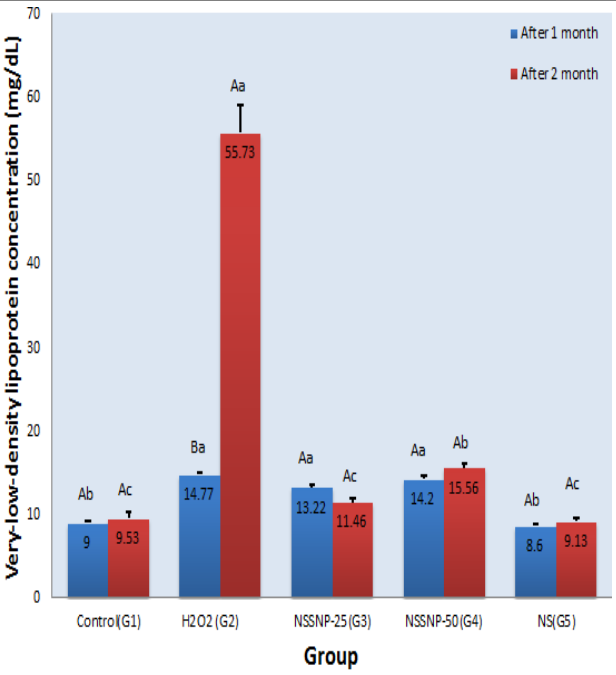
Figure 8 . Effect of two concentrations of Nigella sativa seeds silver Nanoparticles NSSSNPs and Nigella sativa Figure 7. Effect of two concentrations of Nigella sativa extract on serum high-density lipoproteins seeds silver Nanoparticles NSSSNPs and Nigella sativa concentration (mg/dl) in H O exposed rats. Values are 2 2 extract on serum very-low-density lipoproteins expressed as mean±SE (n= 8). Various capital letters concentration (mg/dl) in H O exposed rats. Values are 2 2 denote significant differences P<0.05 between expressed as mean±SE (n= 8). Various capital letters denote significant differences P<0.05 between periods. Various small letters denote significant differences